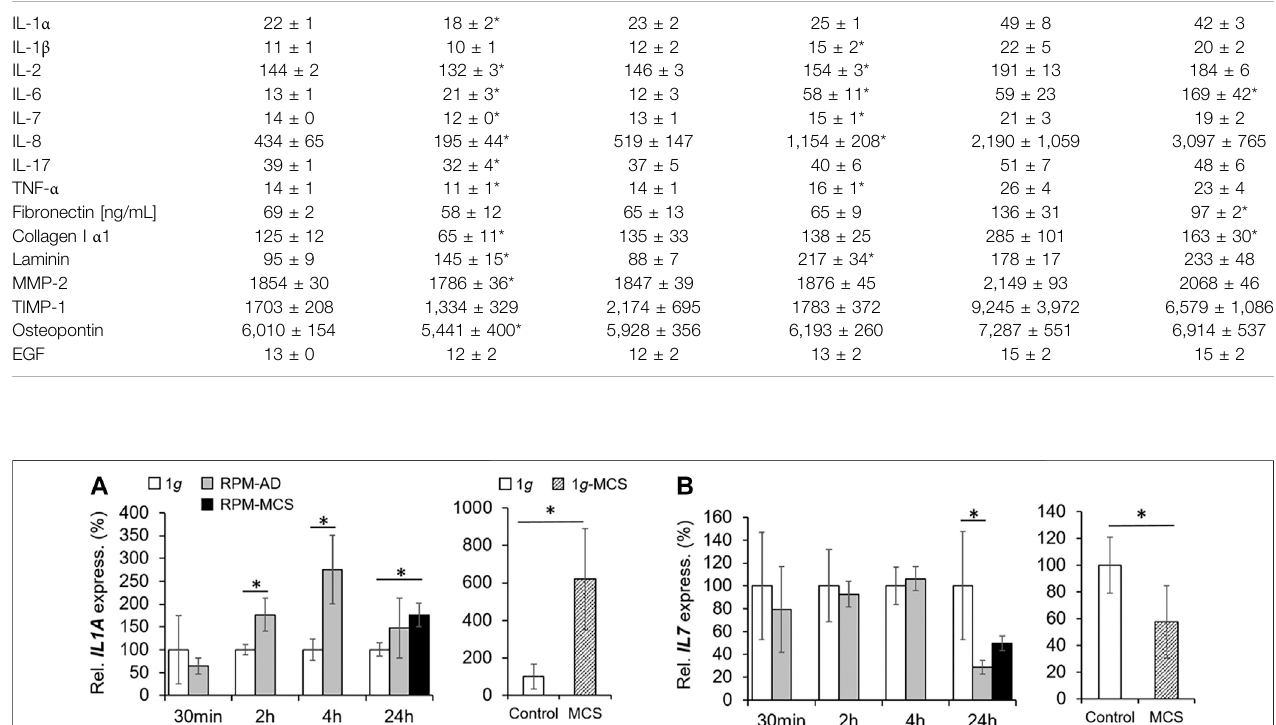
Frontiers in Cell and Developmental Biology |